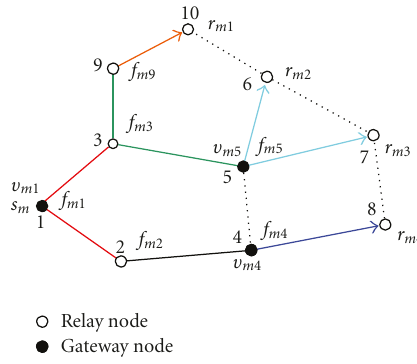
Figure 1: Multirate multicast network